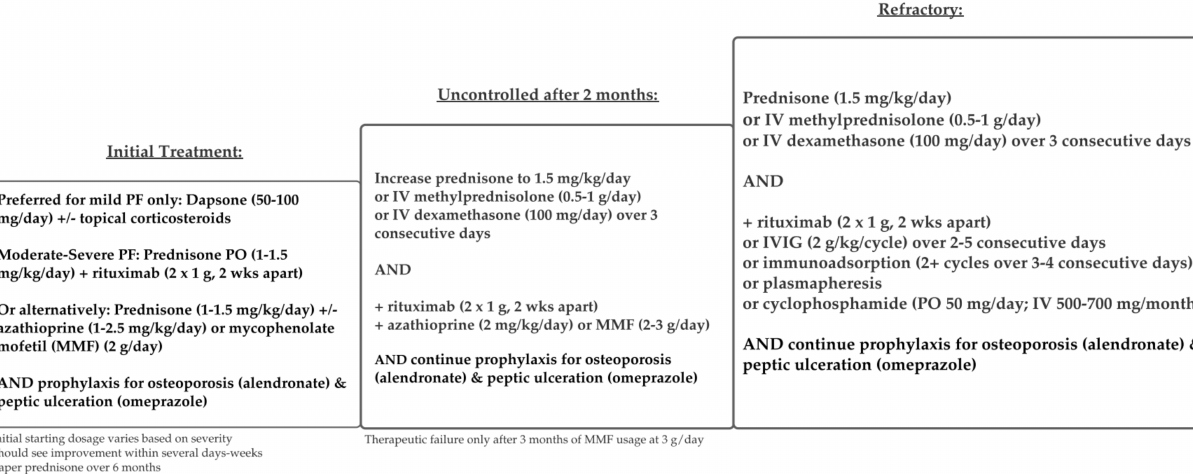
Figure 6. Treatment schema for pemphigus